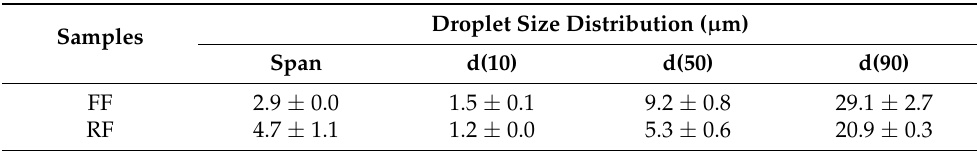
Table 2. Droplet size distribution of FF and RF stored at room temperature. Data were obtained one week after production and are mean ± SD, n = 3.